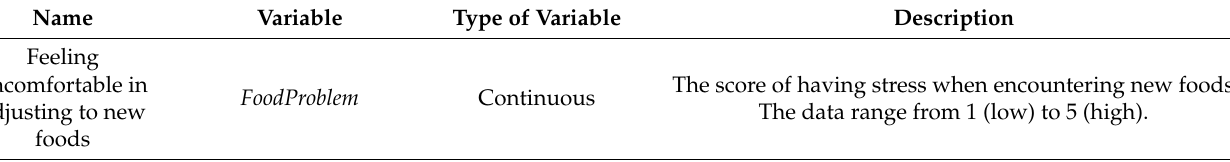
Table 1. Variable